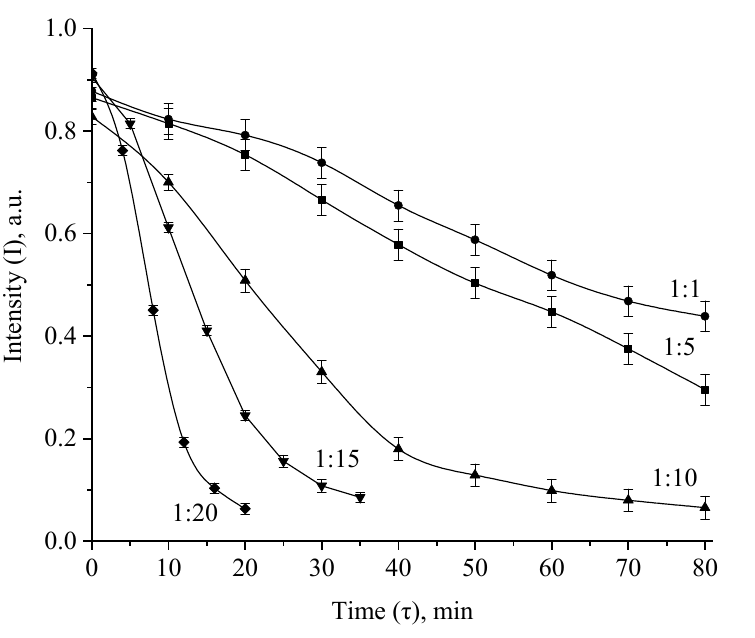
Figure 15. Kinetic dependences of changes in the intensity of the absorption band of the plasmon resonance of Ag NPs during oxidation with H 2 O 2 .